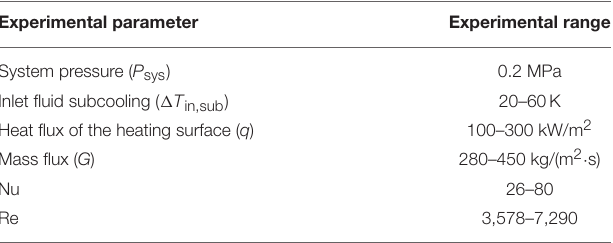
TABLE 1 | Experimental parameter ranges.